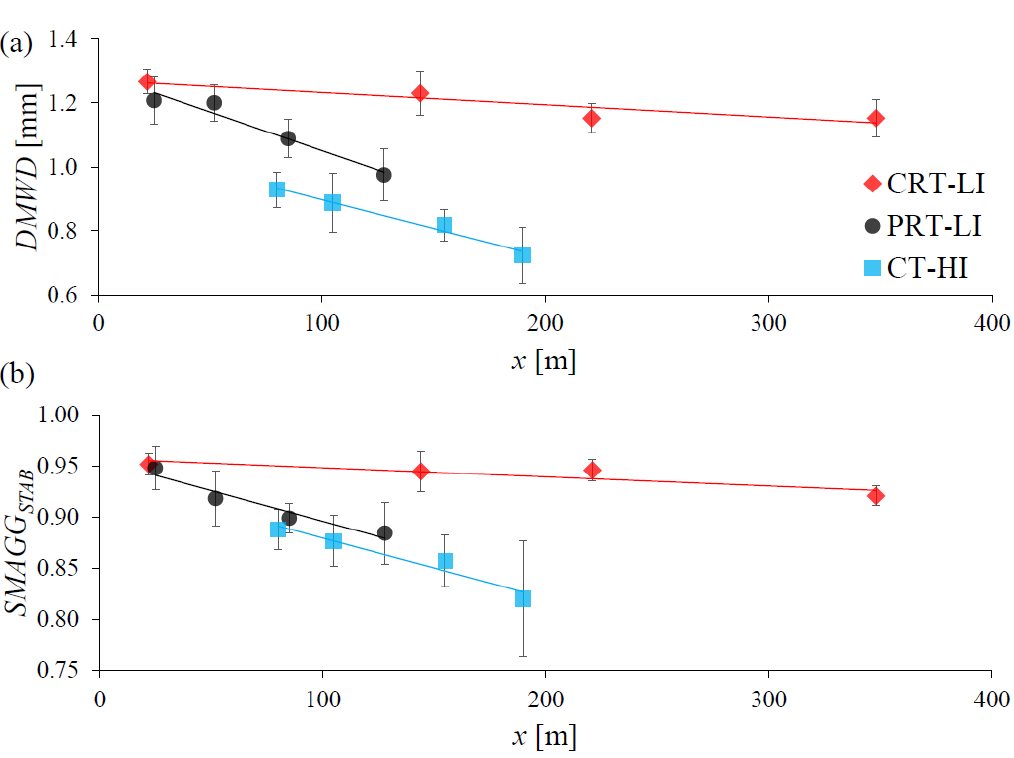
Figure 6. ( a ) relationship between dry mean weight diameter (DMWD) and downslope flowpath distance ( x ); ( b ) relationship between small macroaggregate stability (SMAGG STAB ) and downslope flowpath distance ( x ); the lines represent the linear trendlines obtained for each management condition.